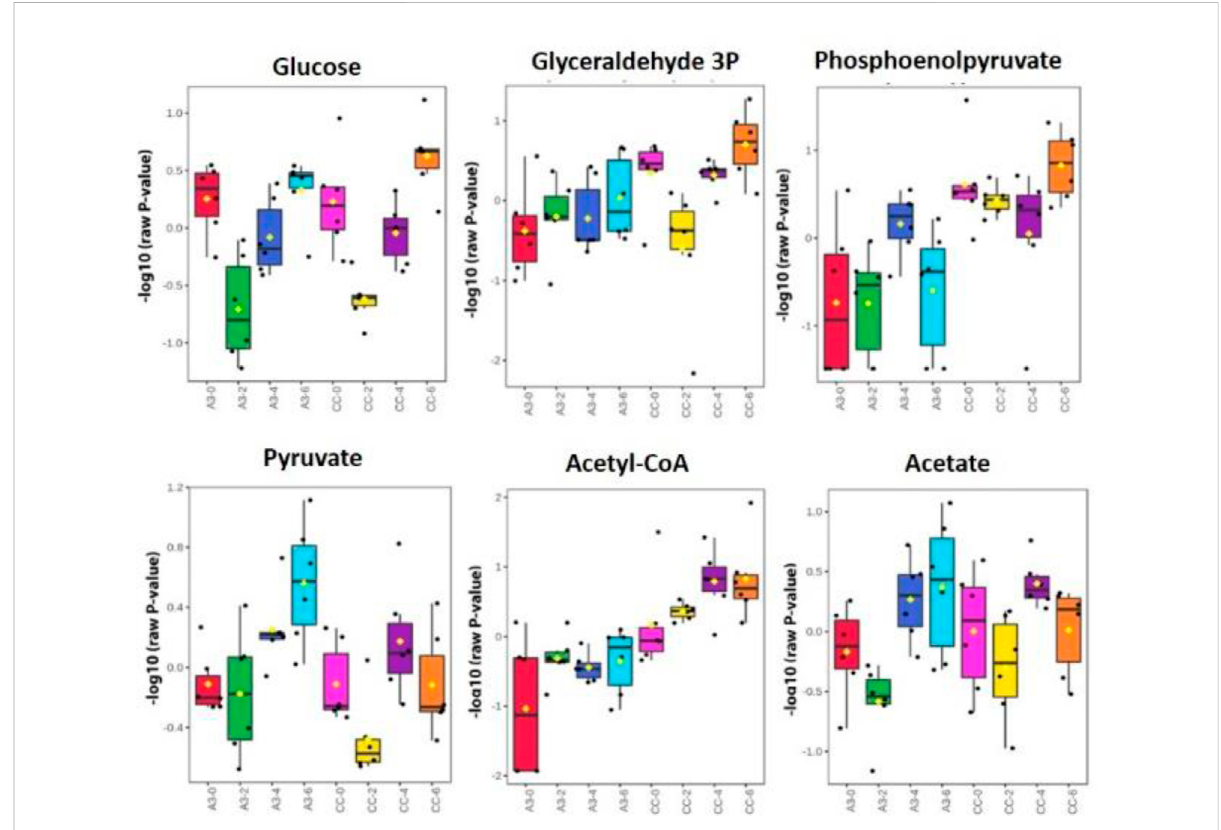
FIGURE 5 Signi fi cantly different metabolite changes in the glycolysis and gluconeogenesis pathway happening at different time points in both treated A3 (Hb5d/e3) and non-treated cells (CC) over time (0, 2, 4, and 6 h).